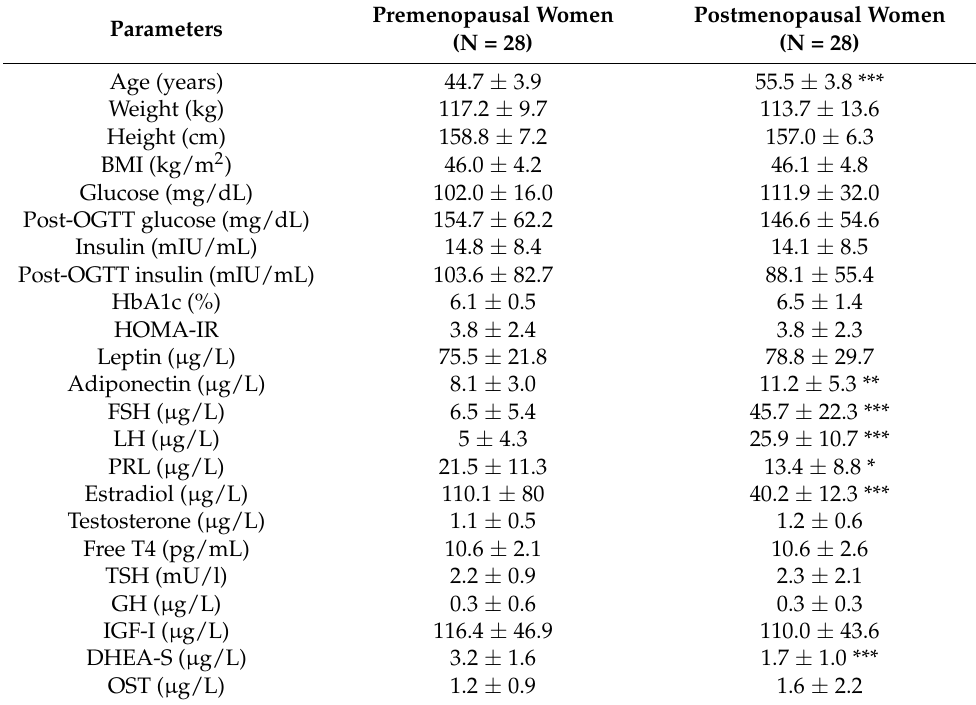
Table 1. Anthropometric and biochemical parameters measured in the study groups. Significance was calculated by two-tailed unpaired Student’s t -test. For significance: * p < 0.05; ** p < 0.01; *** p <